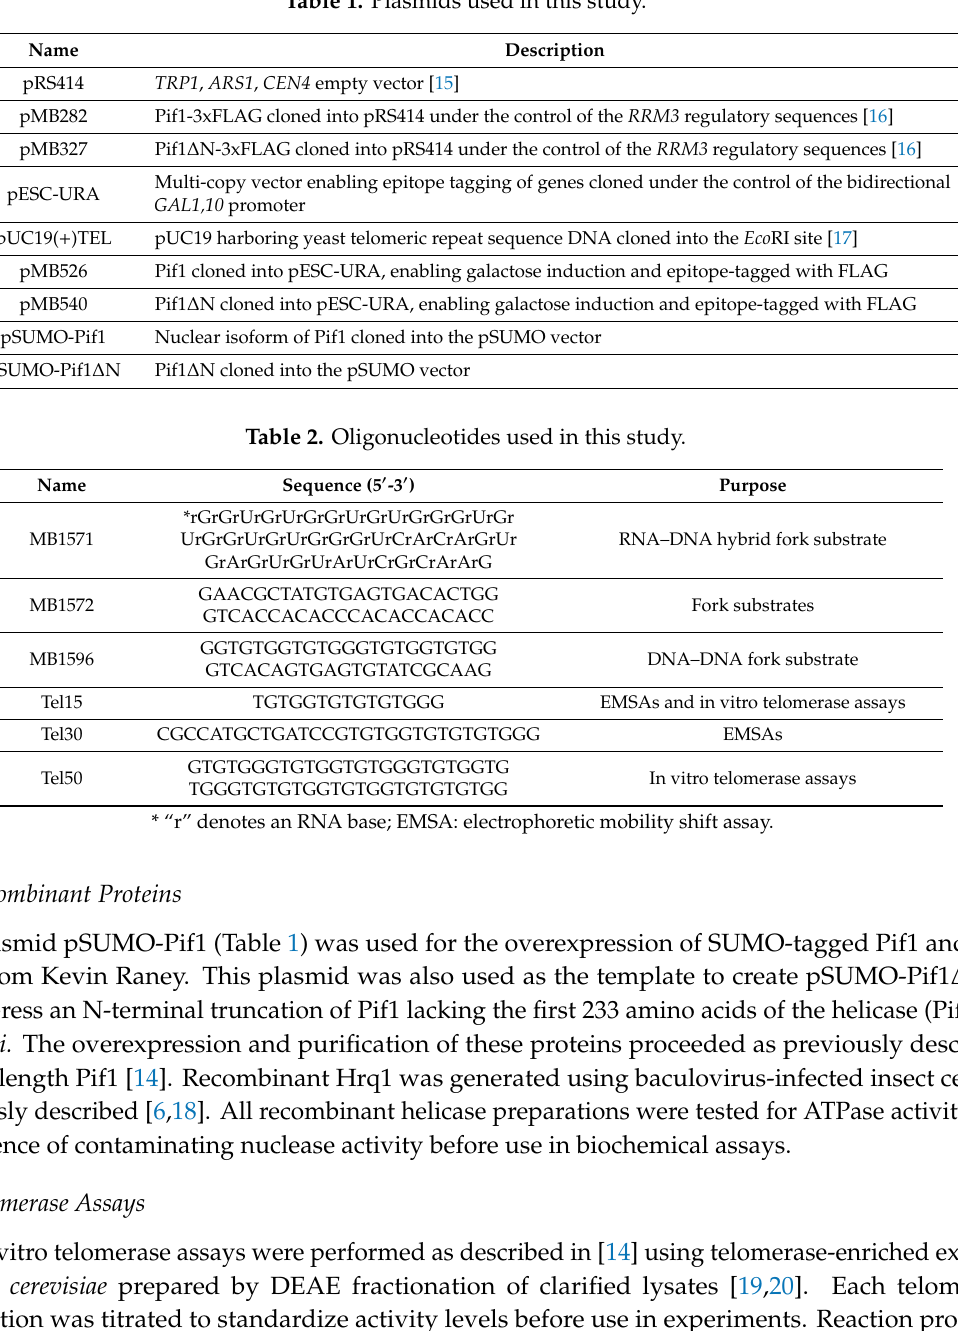
Table 1. Plasmids used in this study.